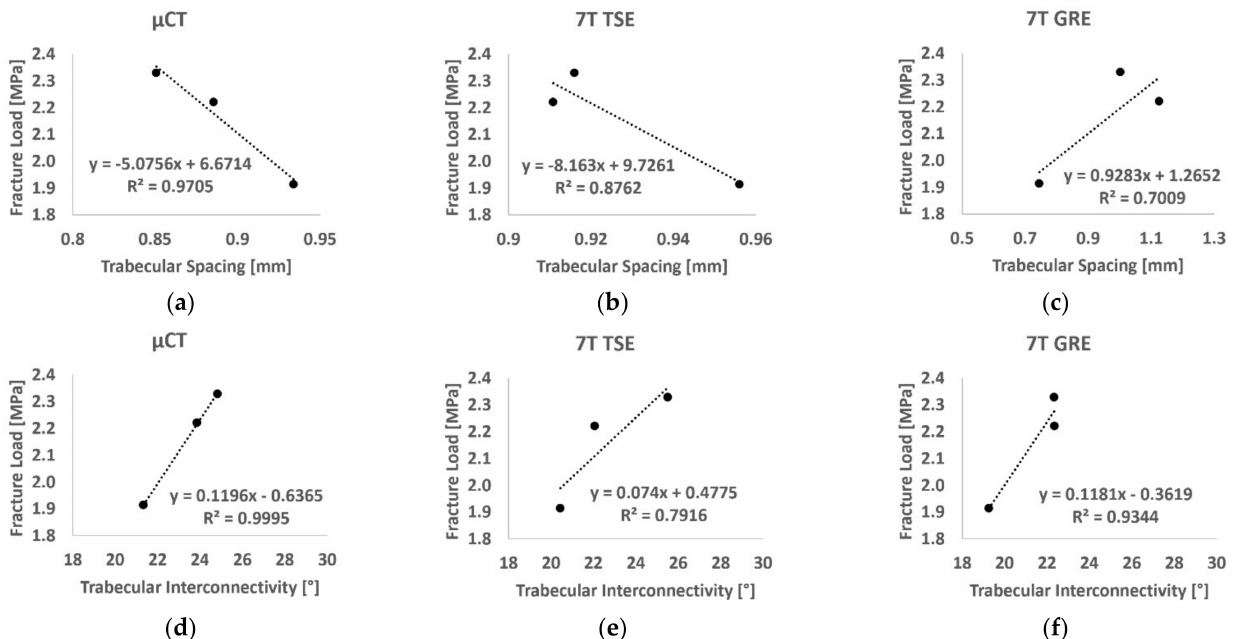
Figure 10. Linear regression between fracture load and trabecular spacing ( a – c ) and trabecular interconnectivity ( d – f ) derived from µ CT images (left), 7T TSE (middle) and 7T GRE